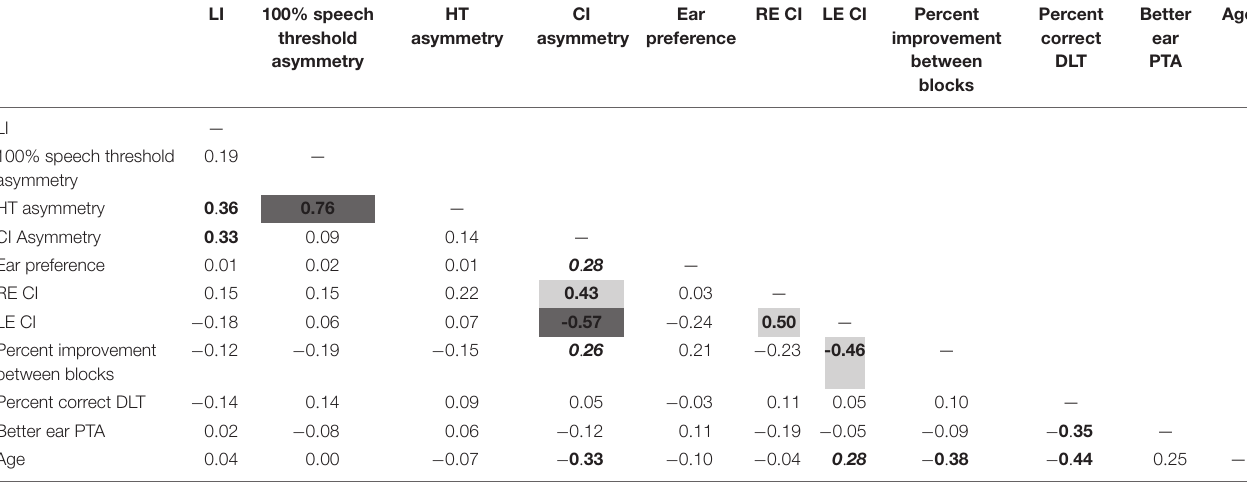
TABLE 1 | Pearson’s correlation coefficients between the main variables of study. Laterality index (LI) has been obtained from dichotic listening task (DLT). LI 100% speech